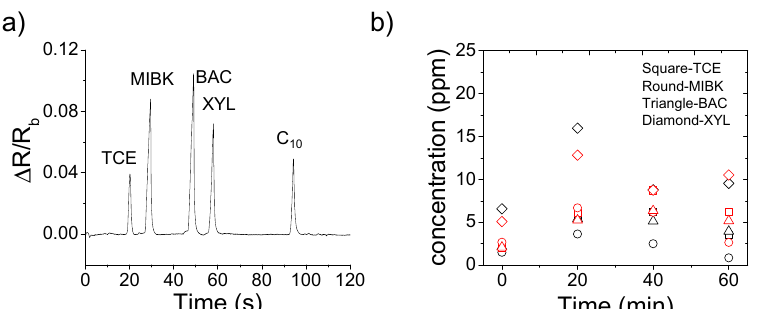
Figure 3. Results from 60 min of autonomous operation of the belt-mounted PEMM in measuring air concentrations of 5 VOCs from a heated/stirred beaker; ( a ) representative chromatogram from the EOE sensor; ( b ) comparison of concentrations from the belt-mounted PEMM (red symbols) and the reference GC-FID (black symbols) for 4 of the 5 VOCs (C 10 omitted). Only 4 of the 12 continuously collected data sets are